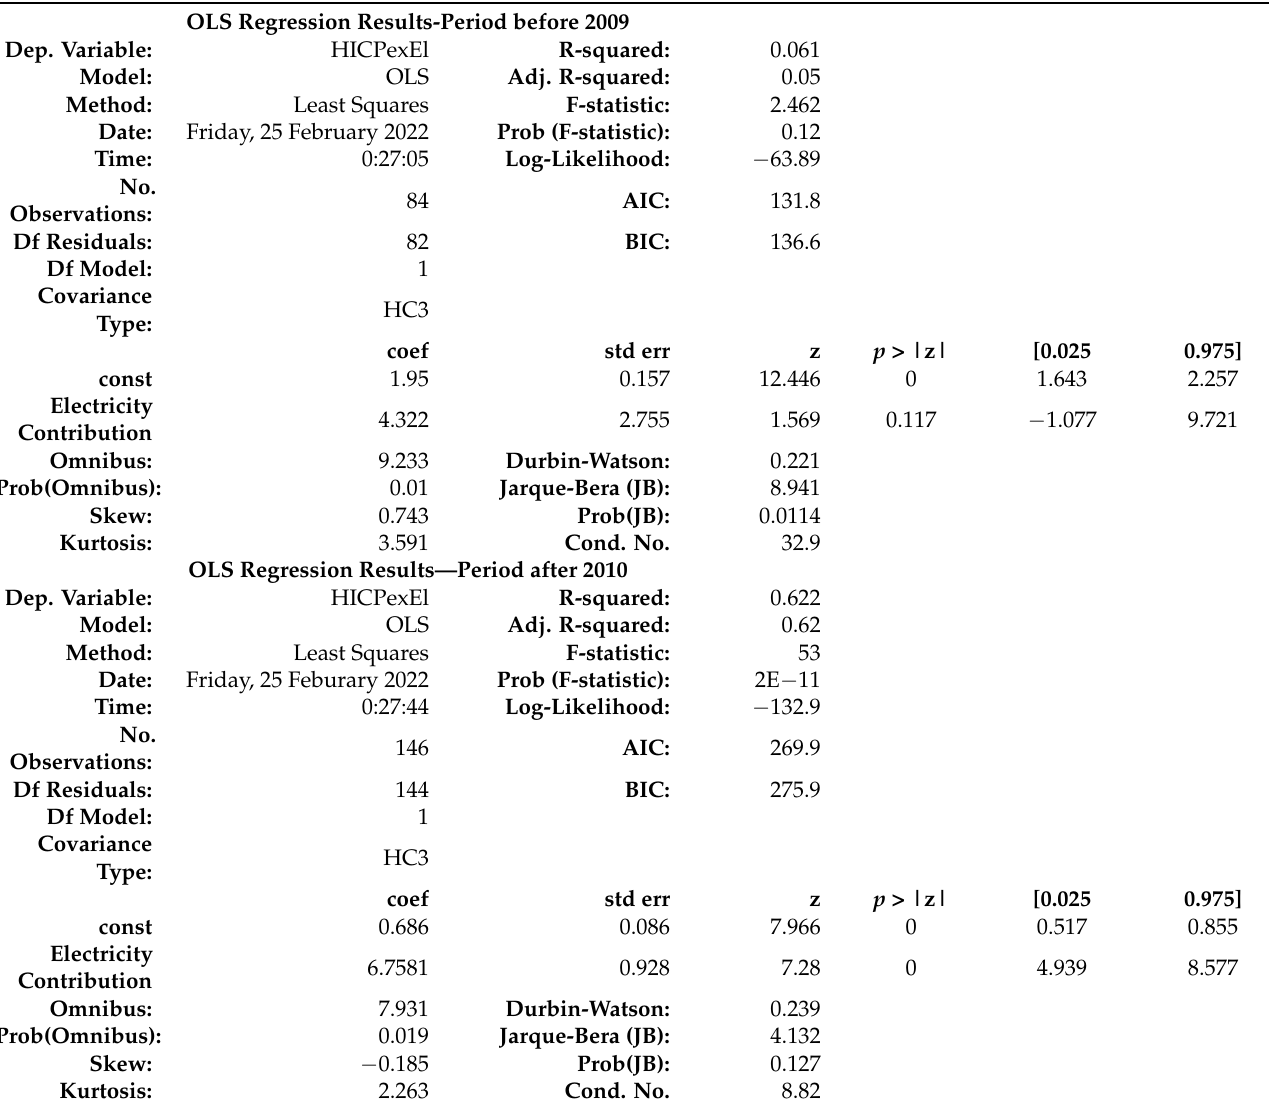
Table 3. OLS regressions of electricity contribution on HICP excluding the electricity